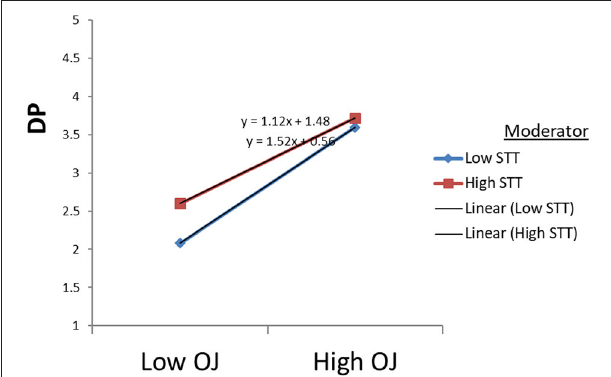
FIGURE 4 | Moderating effects of STT on DP through OJ.